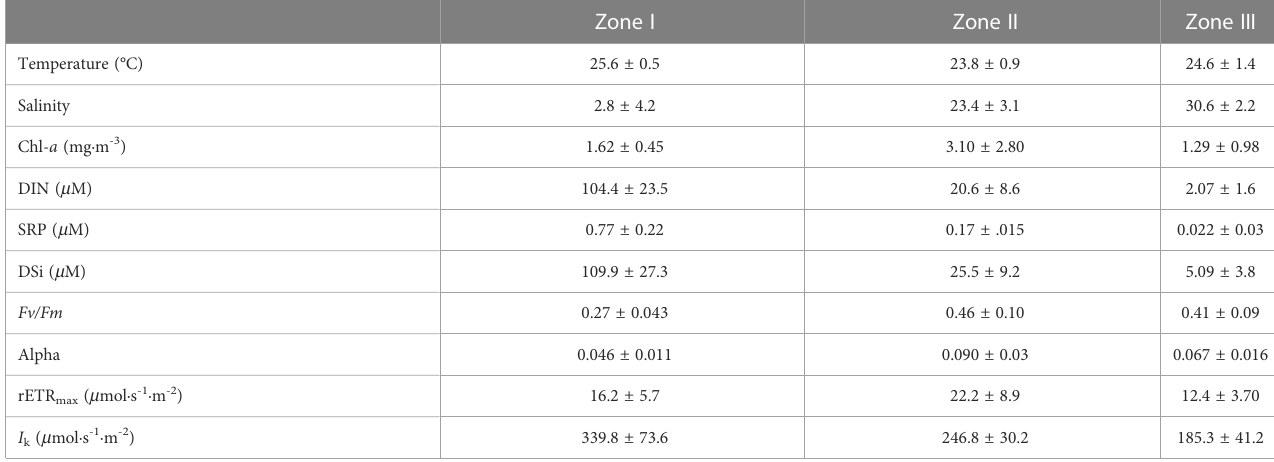
TABLE 1 The mean value and standard deviation of environmental factors, Chl- a concentration, and photosynthetic parameters in three zones of the Changjiang River Estuary divided by the sediment and plume fronts (as de fi ned by Li et al.,